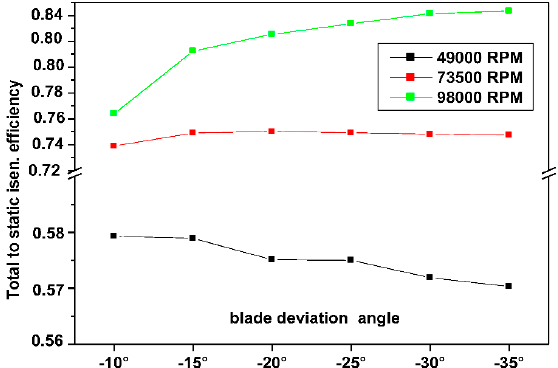
Figure 22. Total to static isentropic efficiency for different deviation blade angles.